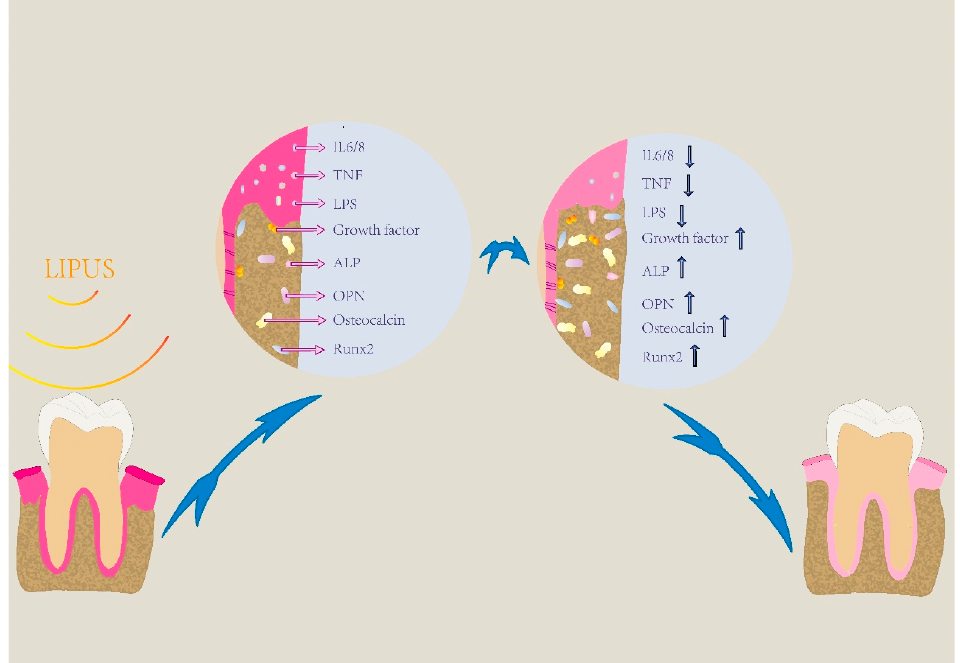
Figure 3. LIPUS plays a dual role in periodontitis. By applying LIPUS, inflammatory factors including IL-6, IL-8, TNF decrease while osteogenesis-related factors increase. Therefore, the inflammatory response and alveolar resorption of periodontitis can be significantly improved.